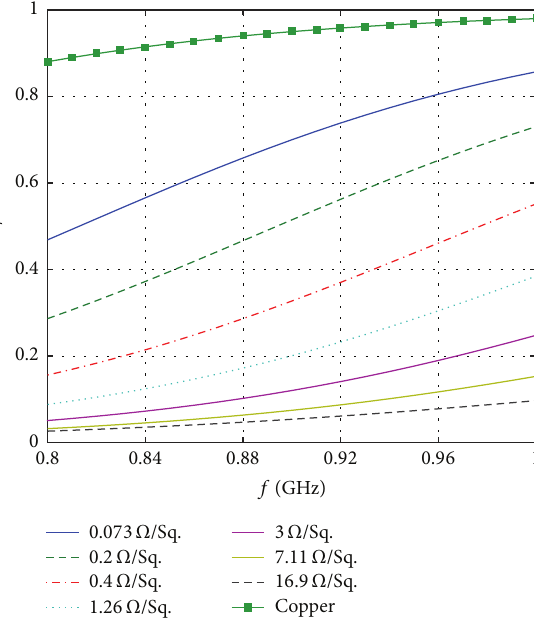
Figure 3: Simulated antenna radiation efficiency.